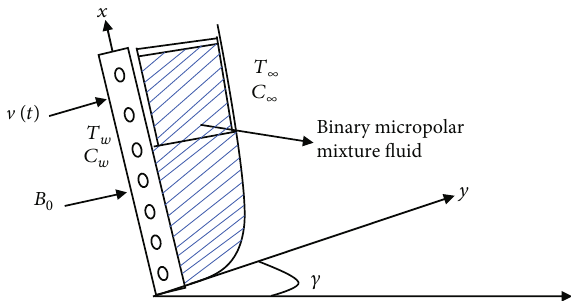
Figure 1: Physical Model and coordinate